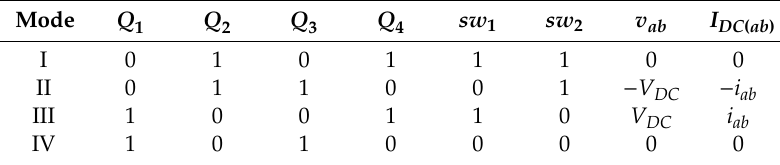
Table 1. Switching states for the line-to-line v AB